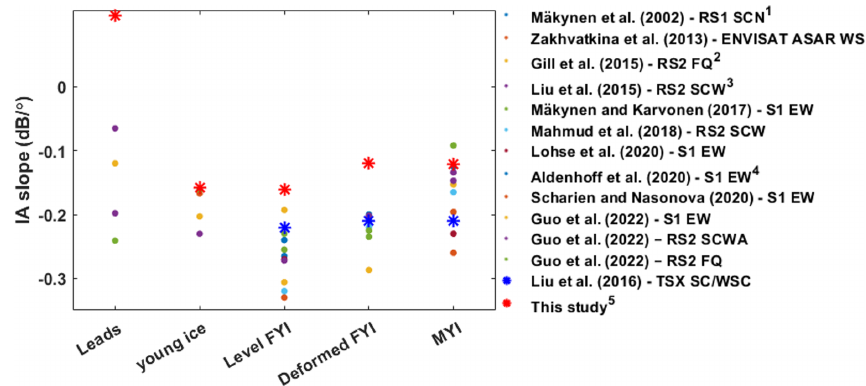
Figure 5. Comparison between IA slope values derived in this work and those from previous studies. Different classification schemes are used for these studies; we summarize these classification schemes into five commonly used classes and display per-class IA slopes for the classes that are the most closely related to these five classes. Dots denote C-band results and asterisks denote X-band results. The correspondence between ice classes shown in the figure and the closest ice classes in the original studies defined differently or more specifically is as follows (see the superscript numbers in the legend): (1) FYI – FYI with dry snow on top; (2) FYI – land-fast smooth FYI with thin (7 . 7 ± 3 . 9cm)